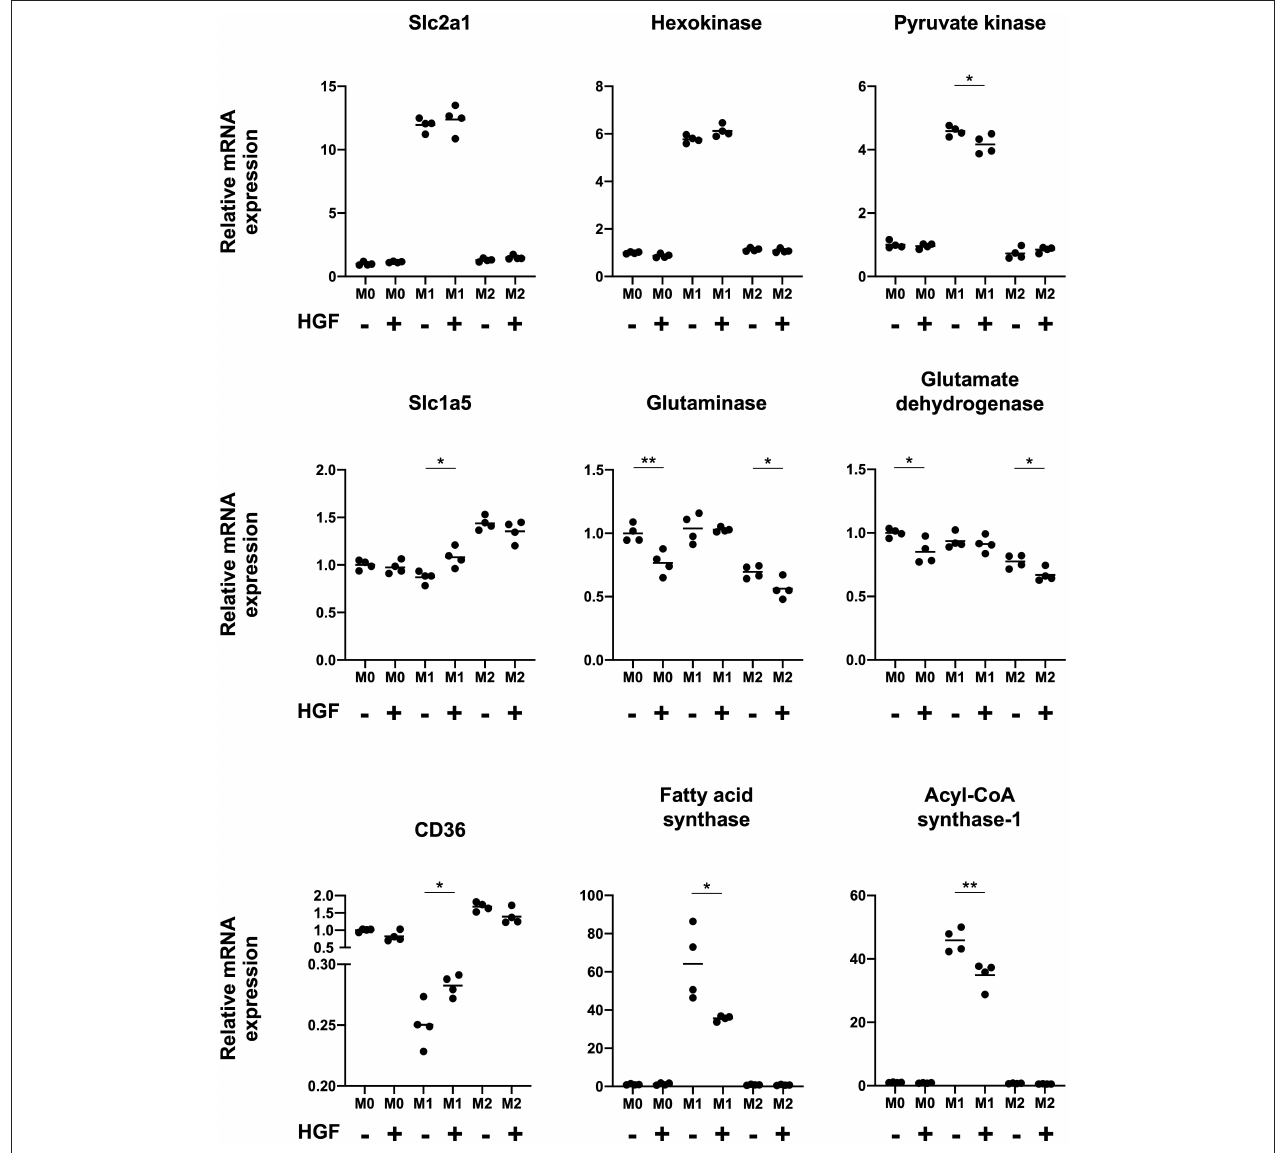
FIGURE 4 | HGF-MET signaling shifts M1 macrophage intracellular metabolism to an M2-like phenotype. Effect of HGF treatment on macrophage intracellular metabolism. RT-qPCR was used to analyze mRNA expression of genes involved in glucose metabolism ( Slc2a1 , hexokinase, and pyruvate kinase), amino acid metabolism ( Slc1a5 , glutaminase, and glutamate dehydrogenase), and fatty acid metabolism ( CD36 , fatty acid synthase, and acyl-CoA synthase-1). The Ct values were normalized to those of β -actin and have been expressed relative to mean level in M0 macrophages not treated with HGF, which is arbitrarily defined as 1. The data are represented as the mean and a scatterplot showing individual data points ( n = 4). Unpaired Student’s t -test, * P < 0.05 and ** P <